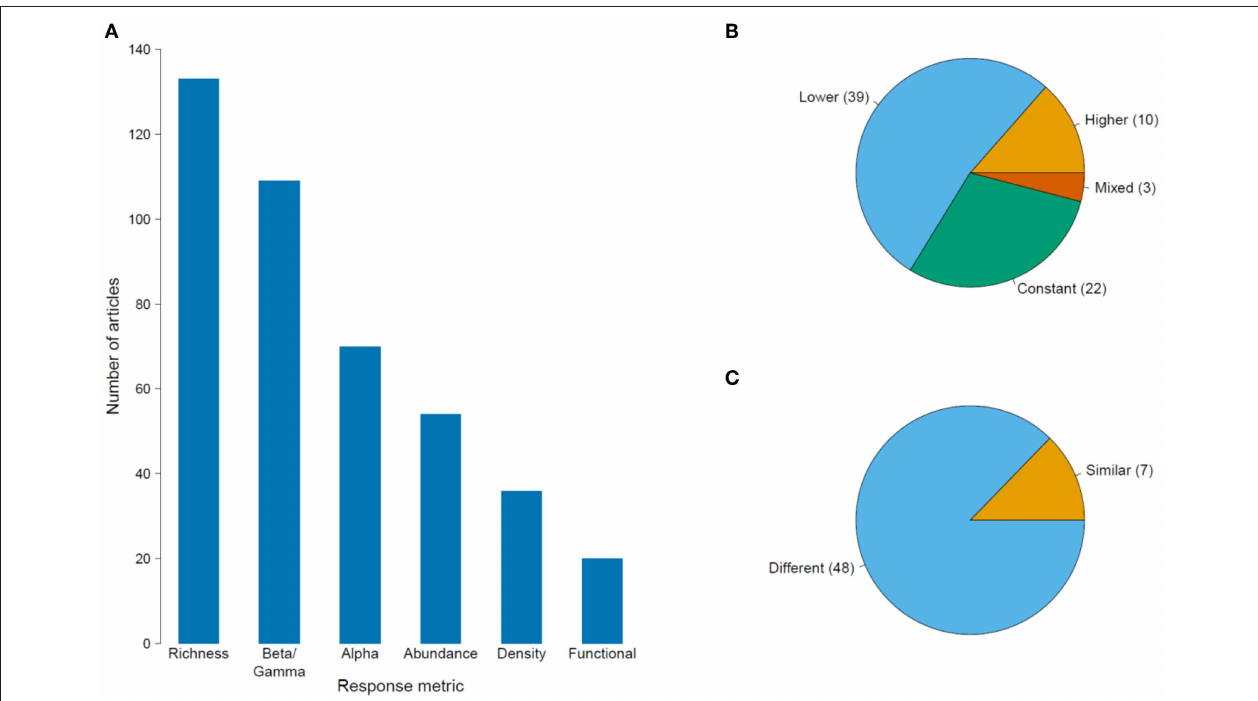
FIGURE 4 | (A) Number of published articles on the impacts of habitat degradation on tropical montane biodiversity using different community response metrics. The proportion of articles showing the community responses to deforestation and habitat disturbance measured using (B) species richness; and (C) species composition. The numbers in parentheses refer to the number of articles for each type of response. For (B) , labels “Lower,” “Higher,” and “Constant” refer to a decline, increase and no change in species richness in disturbed areas in comparison to pristine sites while “mixed” response refers to a unimodal peak along a disturbance gradient. For (C) , labels “Similar” and “Difference” describe if the species composition is the same or different between disturbed and pristine sites.